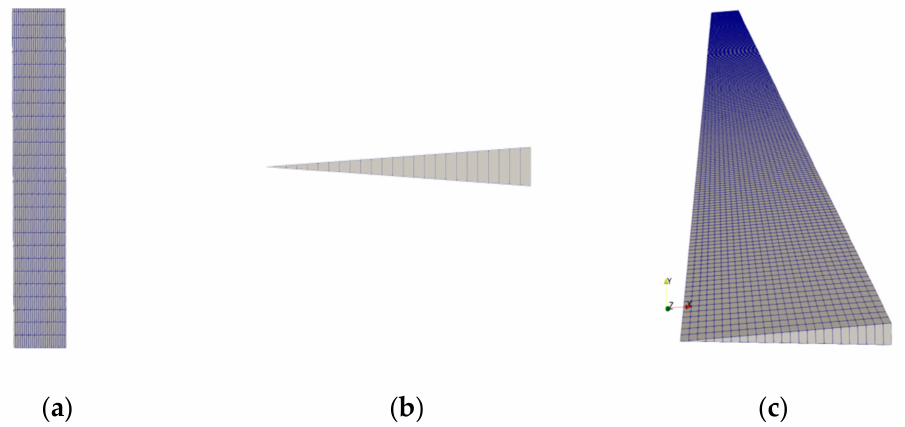
Figure 5. Wedge grid. ( a ) Axial mesh; ( b ) Section mesh; ( c ) Wedge 3D mesh.